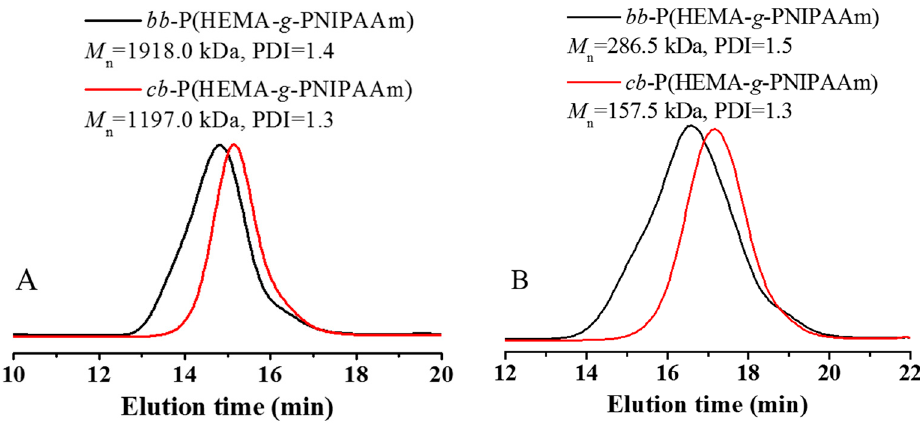
Figure 5. SEC elution traces of bb -P(HEMA- g -PNIPAAm 182 ) 50 and cb -P(HEMA- g -PNIPAAm 182 ) 50 ( A ) and bb -P(HEMA- g -PNIPAAm 42 ) 50 and cb -P(HEMA- g -PNIPAAm 42 ) 50 ( B ) using DMF as the eluent. Table 2. Summary of bb -P(HEMA- g -PNIPAAm) and cb -P(HEMA- g -PNIPAAm) synthesized under different conditions.